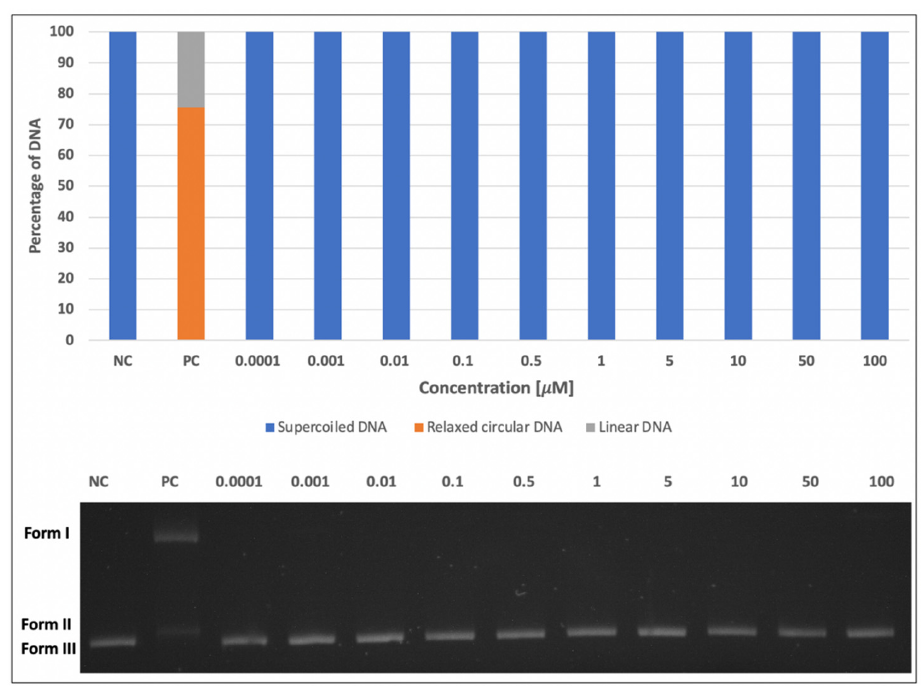
Figure 1. Potential DNA-damaging effects of skyrin on plasmid DNA. Electrophoretic monitoring of changes in the topology of plasmid DNA (pBR322) induced by skyrin (SK) using DNA-topology assay (Form I = relaxed circular DNA; Form II = linear DNA; Form III = supercoiled DNA). Legend: Line 1: pBR322 (negative control-NC); line 2: pBR322 + FeSO 4 × 7H 2 O (positive control-PC); lines 3–12: pBR322 + different concentrations of skyrin. Experiments were performed three times